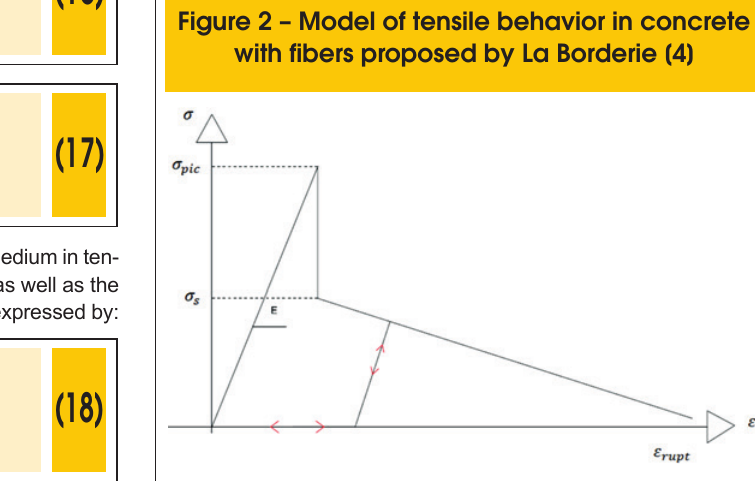
Figure 2 – Model of tensile behavior in concrete with fibers proposed by La Borderie